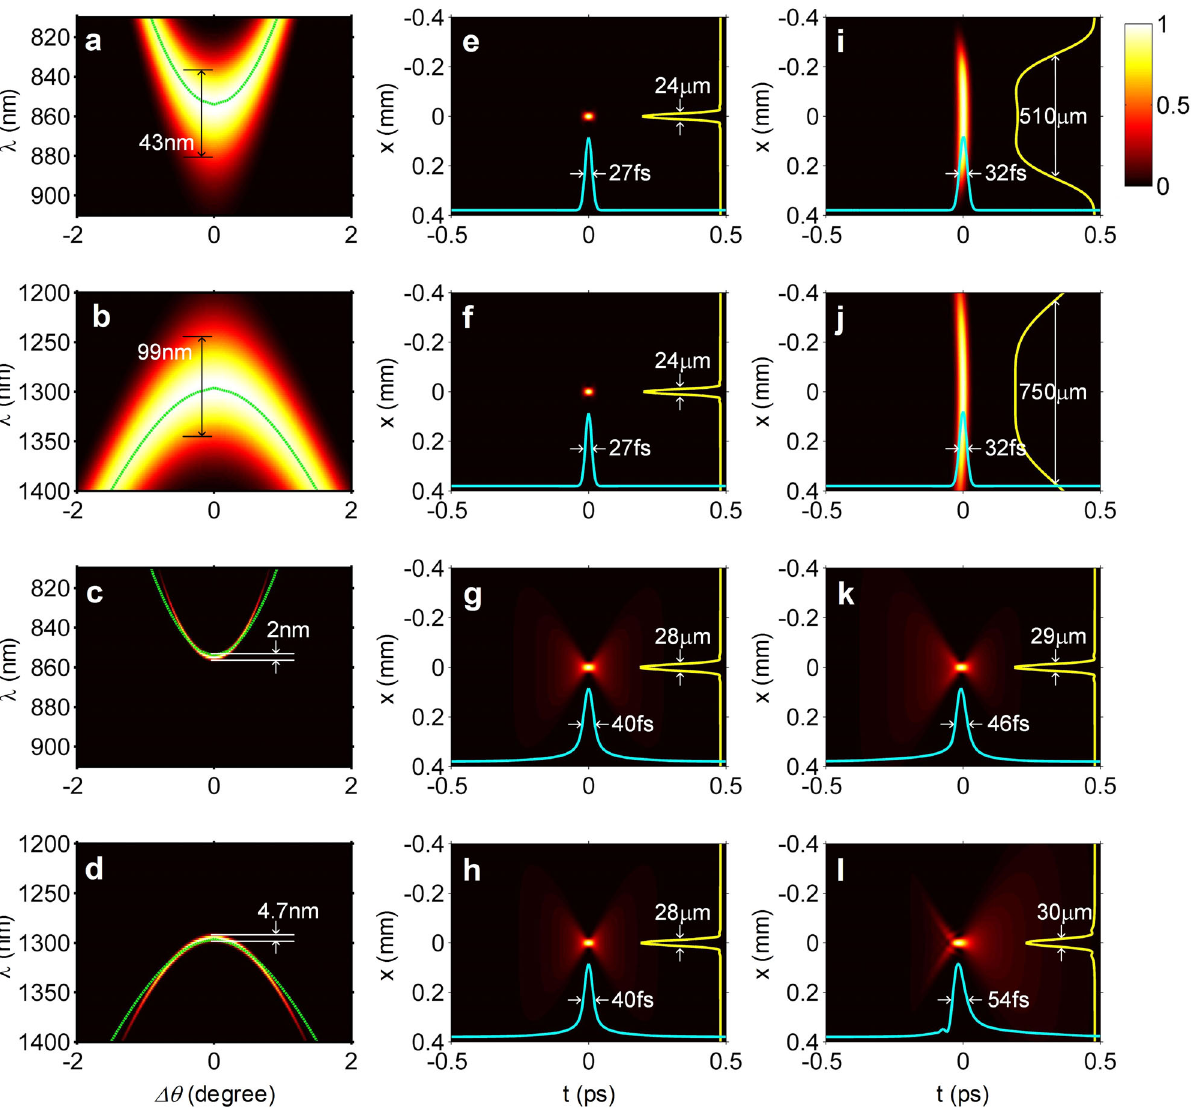
Fig. 3 Space-time (ST) spectra and supported pulsed beams. In a 515 nm pumped type-I BBO crystal with a pump angle θ p = 23°, gain spectra of optical parametric ampli fi cation (OPA)/optical parametric generation (OPG)/optical parametric oscillation (OPO) at a short and b long wavelengths for different directions. When seeding a ST wave packet, ST spectra of c ampli fi ed signal and d generated idler. Green dash lines in a – d are phase-matching curves. Δθ is the angle in the x – z plane with respect to the pump, uncertainties of ST spectra are around 43, 99, 2, and 4.7 nm in ( a – d ). Pulsed beams supported by ST spectra in a – d are shown in ( e – h ), and after 20 mm free propagation those are shown in ( i – l ). t is the local time, all fi gures share a normalized color-bar, and pro fi les and FWHM (full width at half maximum) widths of on-axis pulses and beams are given by curves in ( e – l